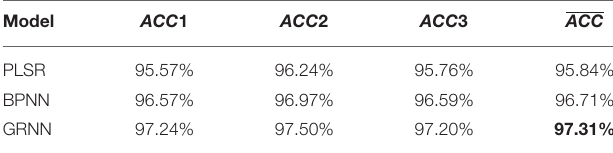
TABLE 2 | Prediction accuracy of different